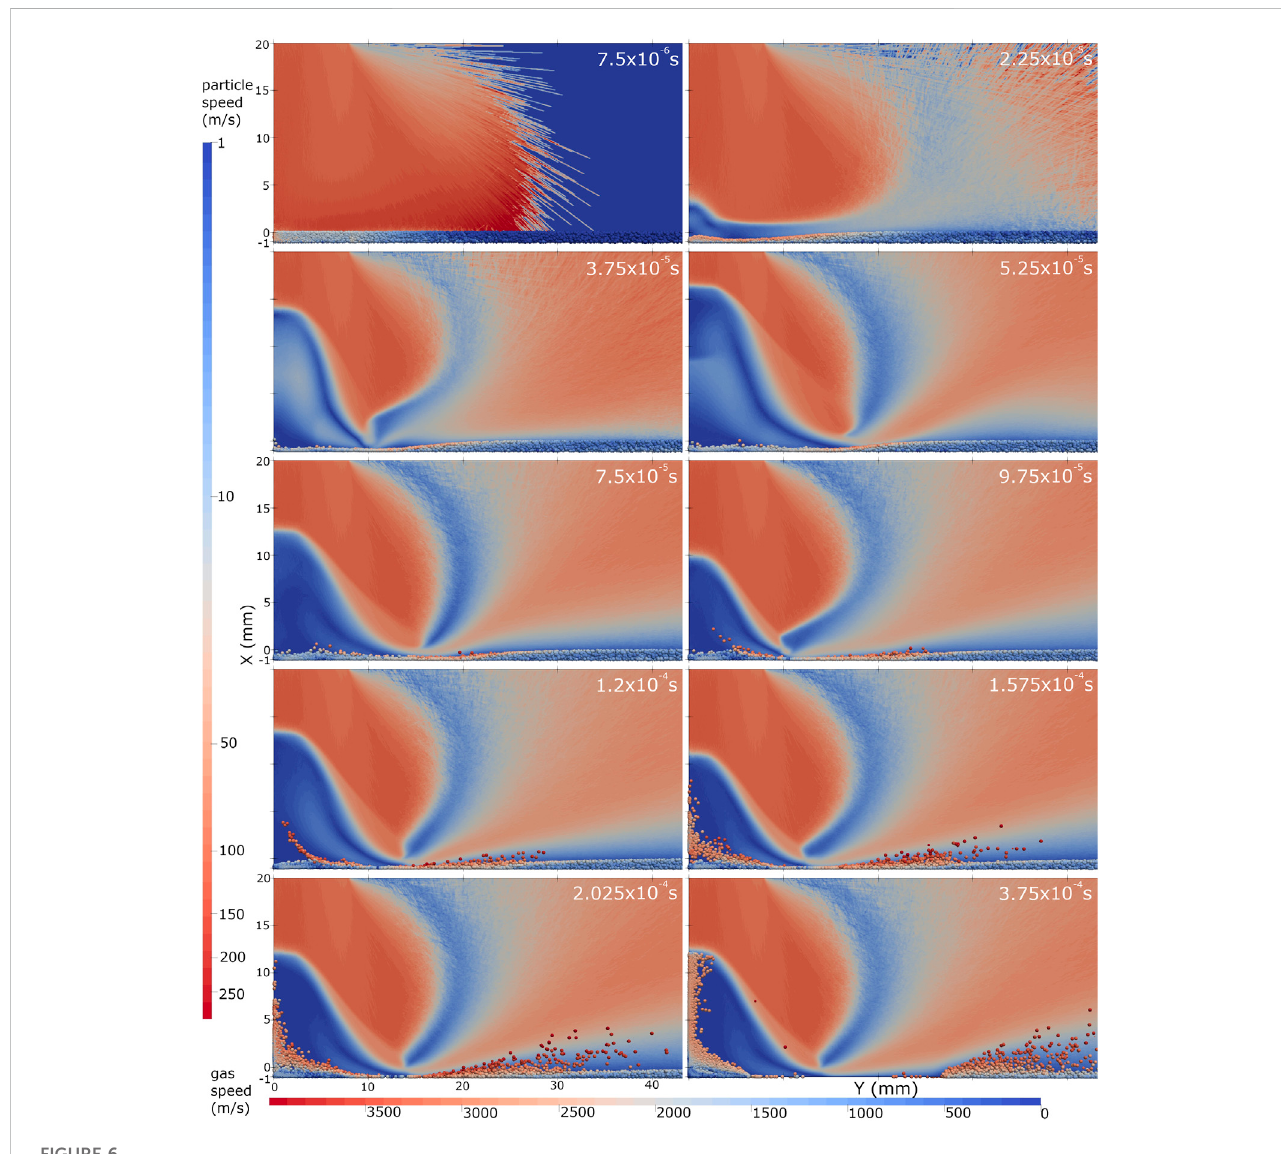
Overview of the two-phase fl ow evolution with the stochastic